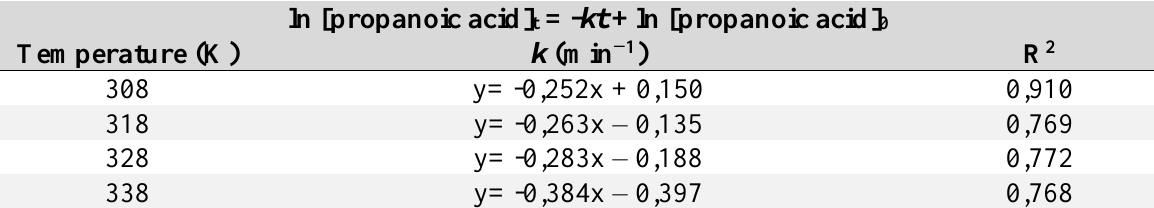
Table 1. Values of rate constant, k , as the slopes of the linear equation (4) and linear correlation coefficient ( R 2 ) for the H SO catalyzed propanoic acid esterification with 1-propanol. 2 4